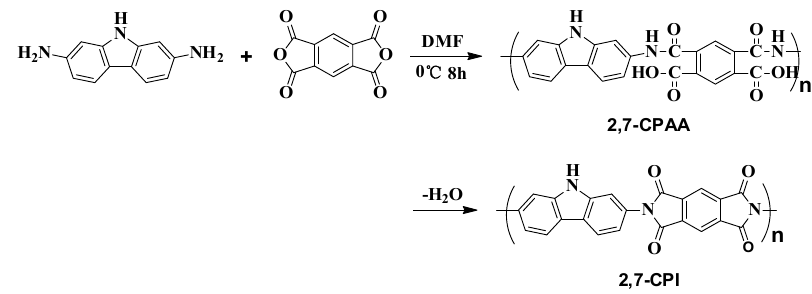
Figure 2. ( a ) 1 H NMR (above: the spectra in the range of 0 ~11 ; below: the partial enlargement in the range of 4.5 ~11 ), ( b ) 13 C NMR, ( c ) H ‐ H COSY, ( d ) C ‐ H QC and ( e ) C ‐ H BC spectra of 2,7 ‐ CPA in